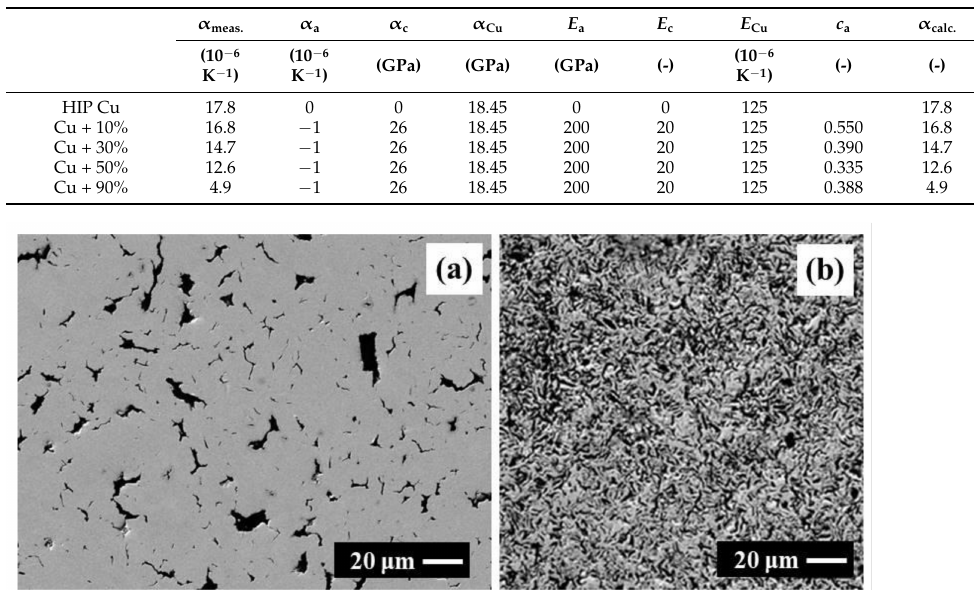
Table 1. Measured CTE, model parameters, and calculated CTE for the investigated Cu–graphite composites at room temperature.